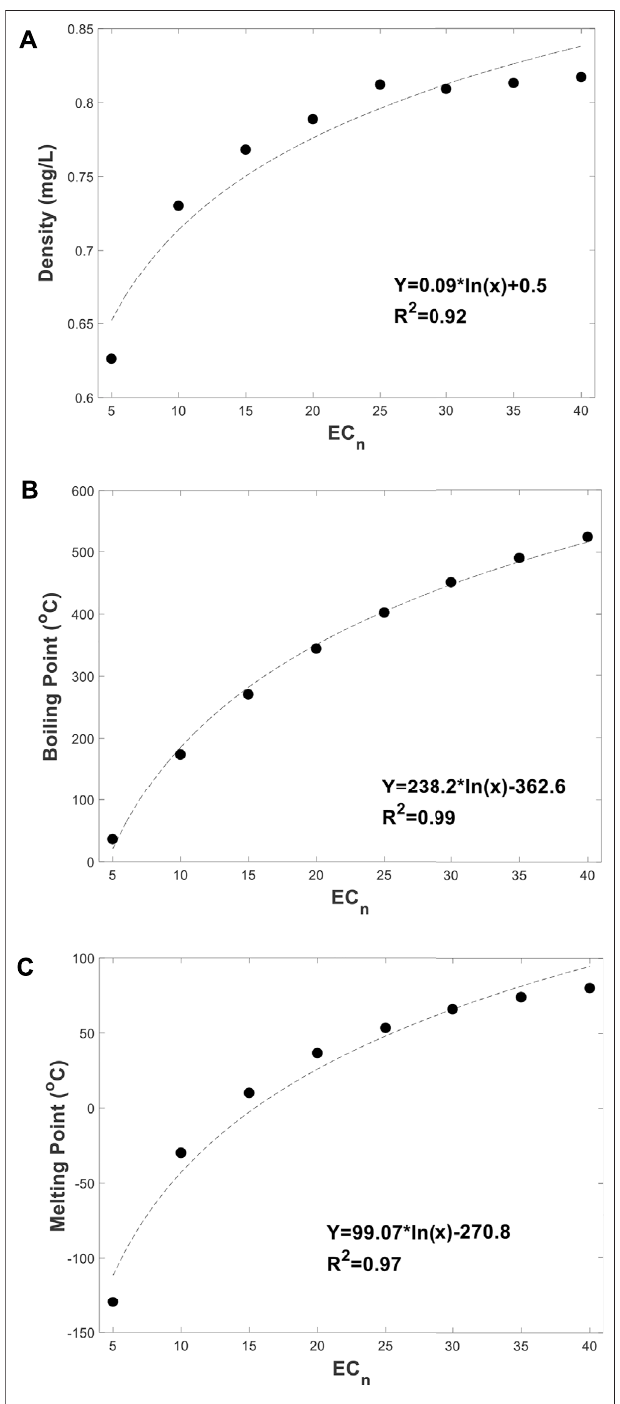
FIGURE 2 | (A) The relationships between the C n and their density. (B) The relationships between the C n and their boiling point. (C) The relationships between the Cn and their melting